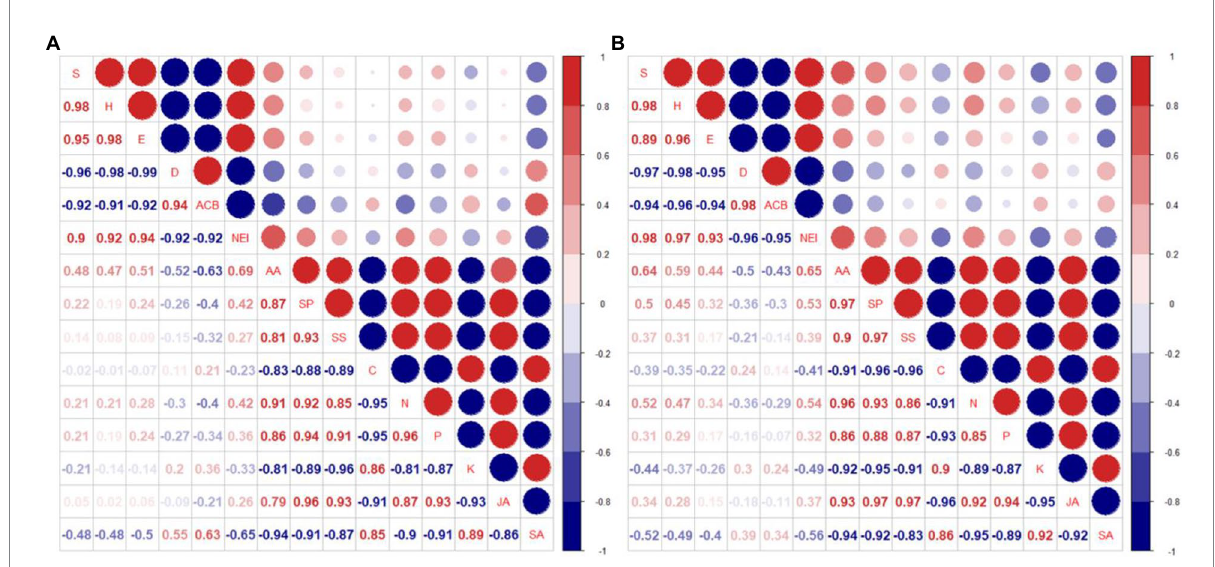
FIGURE 7 Correlation analysis of insect community index ( S, H, E, D ), the prevalence of Asian corn borers (ACB), number of natural enemy insect species (NEI), corn leaf nutrients (AA, SP, SS), nutrient elements (C, N, P, K), and corn leaf plant hormone (JA, SA) in 2018 and 2019 [ (A) Normal fertilizer; (B) Reduced fertilizer. S - Species number; H -Shannon-Wiener diversity index; E -Pielou evenness index; D -Simpson dominance index; ACB: number of Asian corn borers; NEI: number of natural enemy insect species; AA: amino acid; SP: soluble protein; SS: soluble sugar; C, N, P and K: total carbon, total nitrogen, total phosphorus and total potassium in corn leaves; JA: jasmonic acid; SA: salicylic